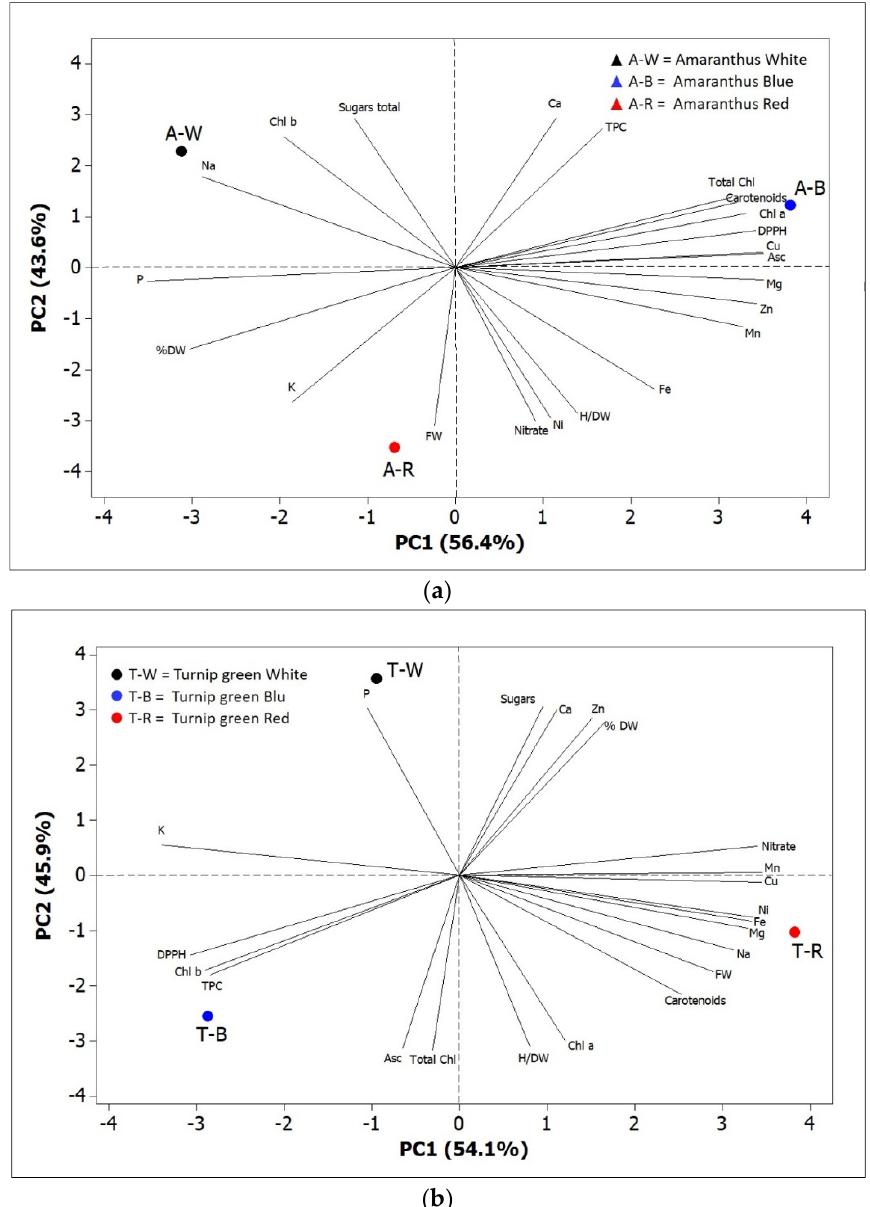
Figure 9. Principal component loading plot and scores of PCA fresh weight and dry biomass, H/DW, photosynthetic pigments (Chl a , Chl b , total Chl, and carotenoids), mineral concentrations (nitrate, Na, Mg, P, K, Ca, Mn, Fe, Ni, Cu, and Zn), DPPH, TPC, total sugars, Asc, and total phenolic concentrations for amaranth ( a ) and turnip greens ( b ) as modulated by LED treatments. W = white LED treatment; B = blue LED treatment; R = red LED treatment.